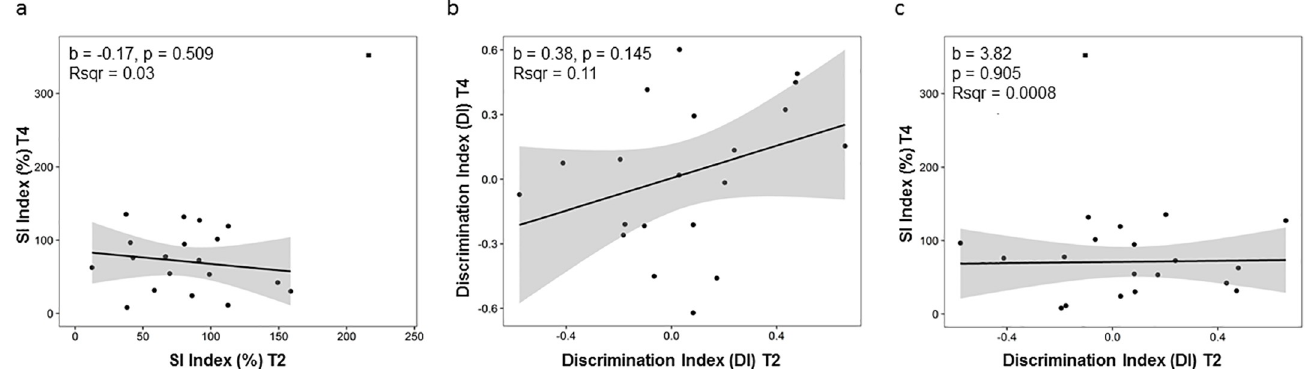
Fig 4. Linear regression analysis for social interaction and novel object recognition. (a) SI scores at timepoint T2 did not significantly predict SI behavior at T4. (b) DI scores at T2 did not significantly predict DI scores at T4. (c) DI scores at T2 did not significantly predict SI scores at T4. One animal was excluded from the regression analysis of SI scores due to being a statistical outlier (shown as a rectangle on the plots). For each regression analysis, the regression coefficient b and the amount of variance explained (R-squared) are shown. The gray area around the regression line corresponds to the 95% confidence band. Non-linear trends in the relationship were investigated using a general additive model. Goodness of fit was not improved as confirmed by a likelihood ratio test, therefore a linear model was fitted to the data.